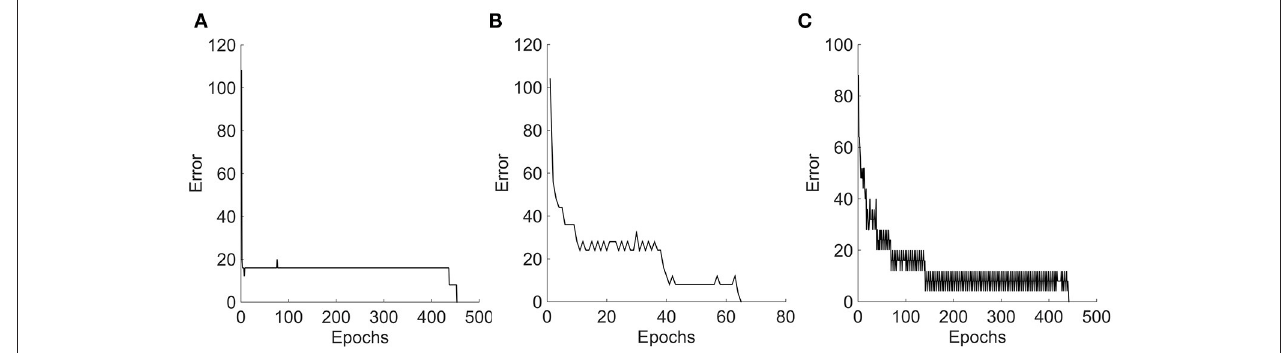
FIGURE 9 | Error graphs obtained during the perceptron training. (A–C) Represents the error plots obtained for Bar, Square, and Plaids respectively, during the perceptron training. The NF layer encodes the motion information of moving stimuli as a unique neuronal population response over a network space. Perceptron takes this population values as input and learns the pattern in the input. The complexity of this response pattern is low to the bar and high to the plaids. The perceptron trained on less complex bar input converges with smooth error graph and the fluctuations were seen in the error graphs of the other two which were proportional to the complexity of the input.